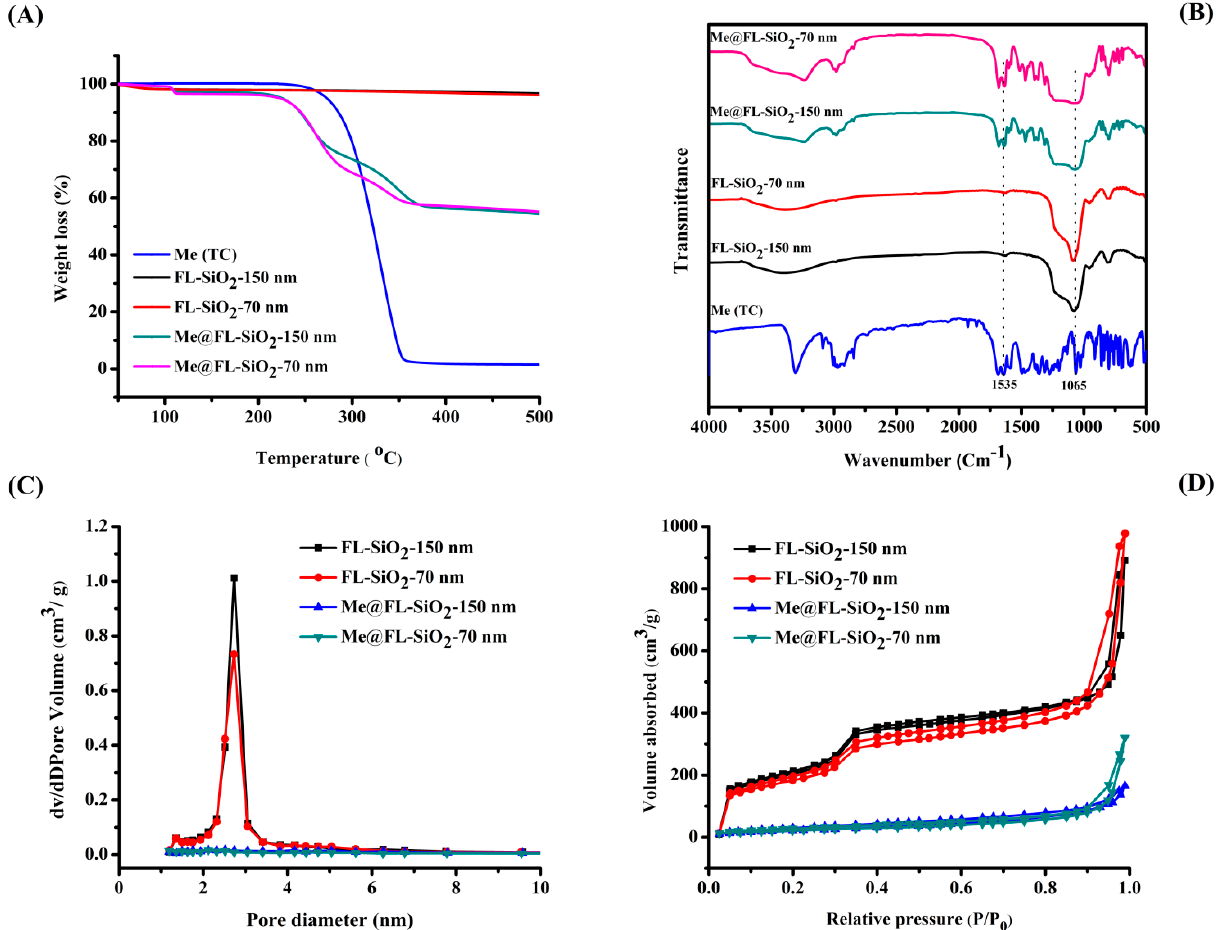
Figure 2. TGA curves ( A ), FT-IR spectra ( B ), Nitrogen adsorption–desorption isotherms ( C ), and pore size distributions ( D ) of methoxyfenozide (Me), FL-SiO 2 NPs-70 nm, FL-SiO 2 NPs-150 nm, Me@FL-SiO 2 NPs-70 nm, and Me@FL-SiO 2 NPs-150 nm. The FTIR spectra of methoxyfenozide, FL-SiO 2 NPs, and Me@FL-SiO 2 NPs were recorded using a Nicolet 6700 FT-IR spectrometer (Figure 2B). The typical peak at 1065 cm − 1